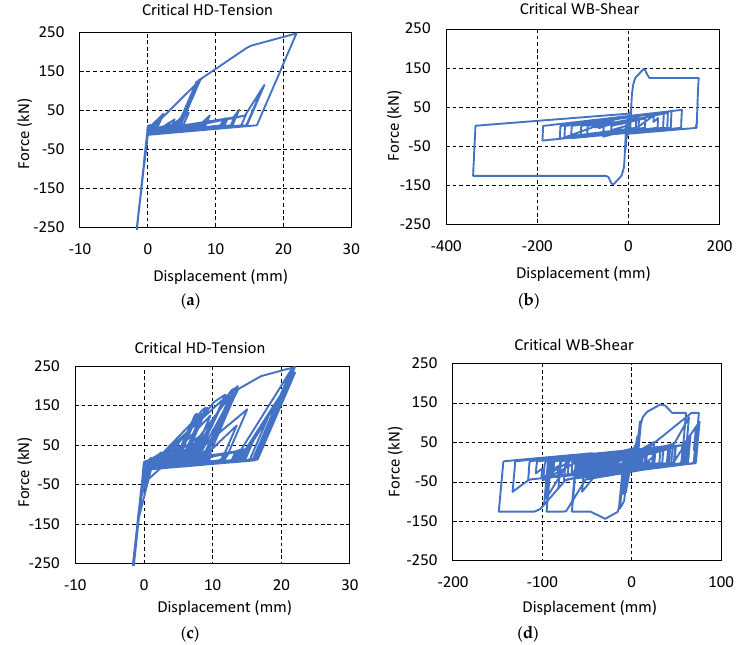
Figure 9. Nonlinear behavior of a critical ( a , b ) HD and WB connection under the SD record; ( c , d ) HD and WB connection under the LD record before collapse. Buildings 2022 , 12 , x FOR PEER REVIEW Figure 10 illustrated the IDA curves for the building model subjected to long and short duration motions, at different intensity levels in the weak direction. Each black dot on the curve represents the onset of collapse, which means the building will collapse at the next intensity level. At the design intensity level (100% of UHS), the maximum IDRs were less than 1% under both sets of ground motions. However, with the increase of in- tensity, the influence of duration was observed. The IDA curves indicated that the esti- mated IDR for SD motions ranges from 2.2% to 9.7% whereas the IDR for LD motions ranges from 0.9% to 6.5%. Moreover, the SD motions reach an average maximum IDR of 4.8% before causing collapse. In contrast, the LD motions reach an average maximum IDR of 3.6% before collapse. This shows that LD motions are more likely to cause overall in- stability which will lead to collapse of the building. This finding is in agreement with re- cent studies on a steel moment frame [14] and light-frame wood buildings [12,13].